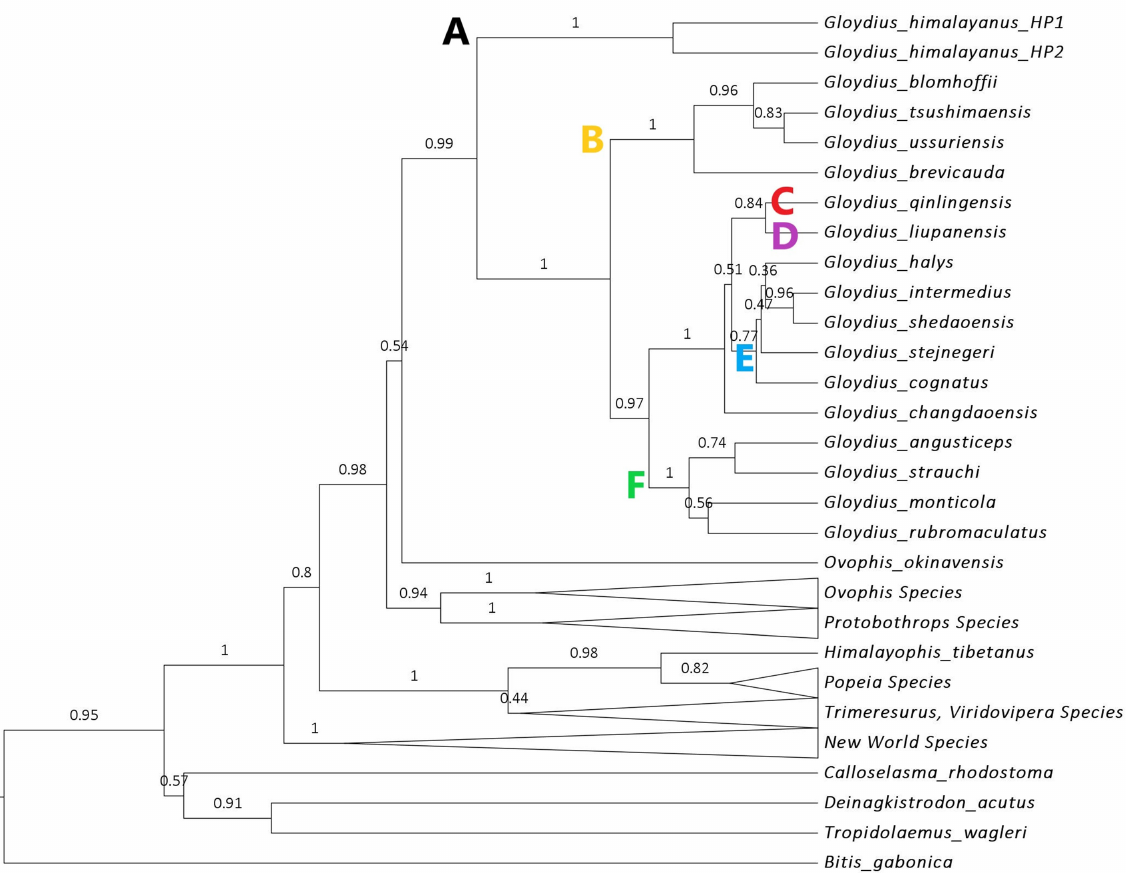
Fig. 3. Multispecies coalescent tree from *Beast. The tips indicate the assigned taxa, and branch labels are posterior probabilities. Clades A–F are as in Fig. 2. The tip labelled “Gloydius_himalayanus_HP1” corresponds to the Chamba specimens and HP2 to the samples from eastern Himachal